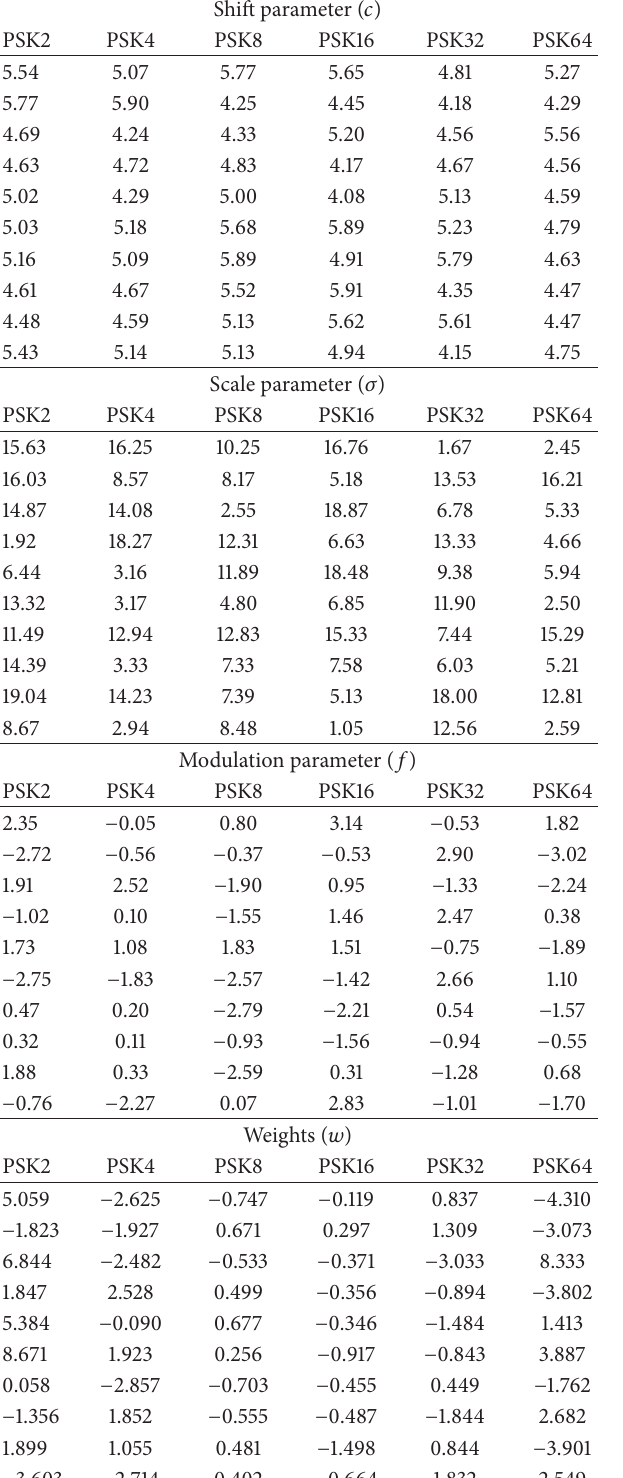
Table 2: Updated Gabor filter atom parameters and weights for FSK modulation